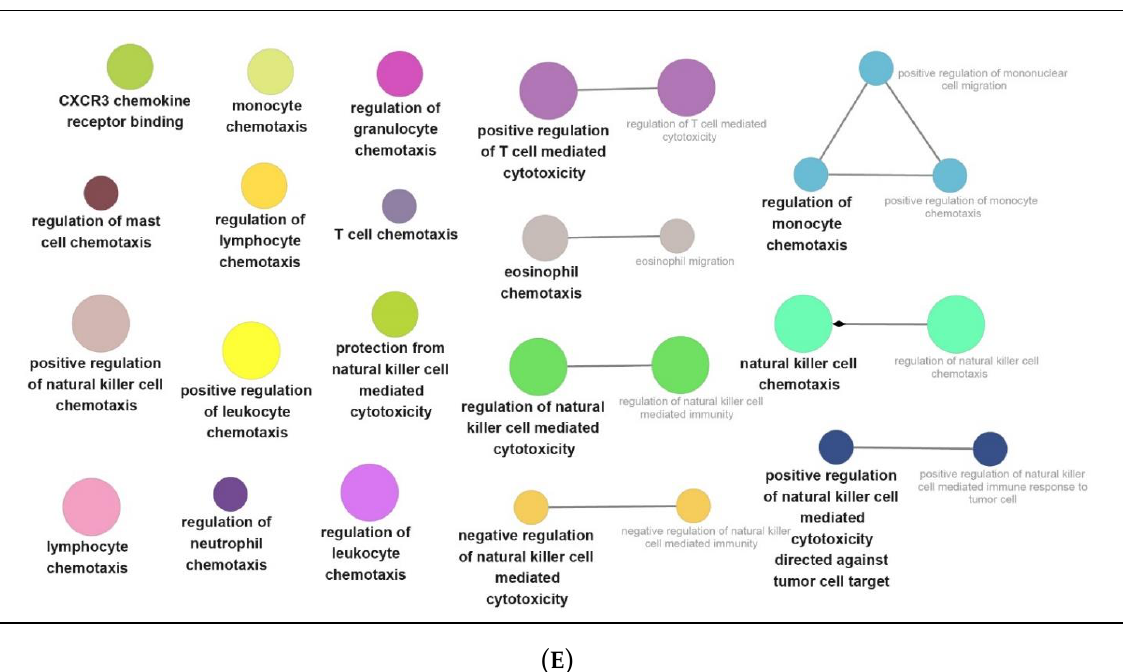
Figure 7. Functional enrichment analysis of up-regulated DEGs from ClueGO. ( A ) Nitric oxide production; ( B ) immune signaling pathways; ( C ) Toll-like signaling pathways; ( D ) activation and differentiation of immune cells; and ( E ) chemotaxis and cytotoxicity of immune cells. Table 2. Hub genes of NPFF-treated BMDMs.